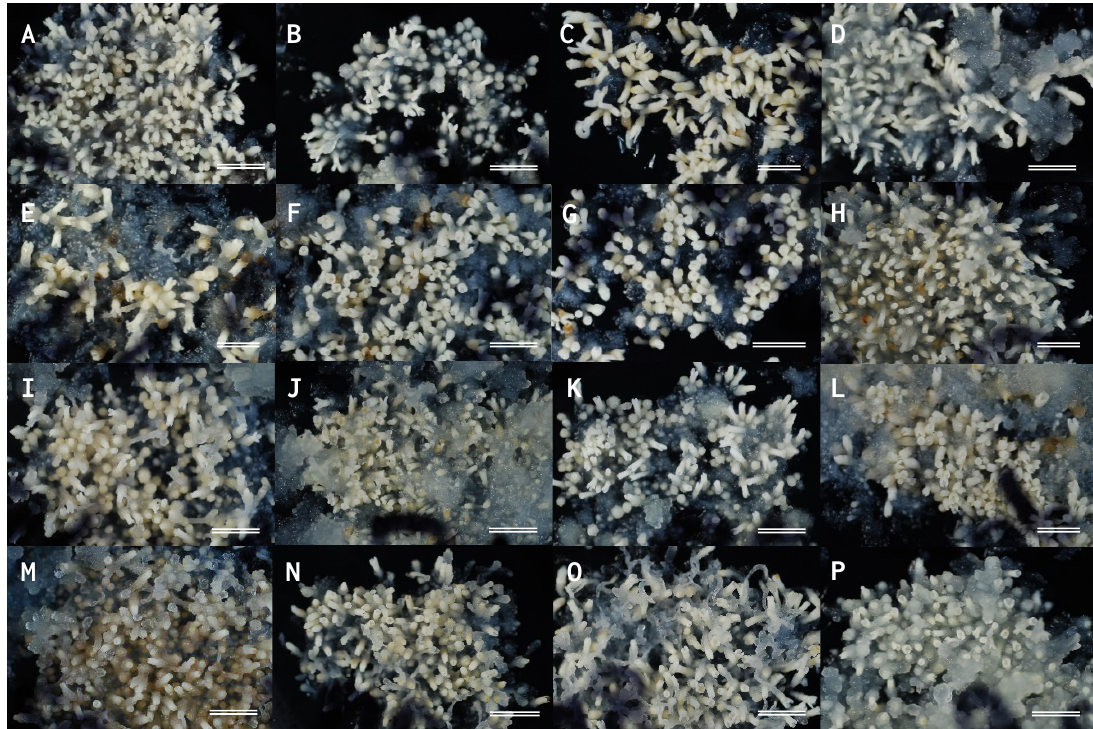
Figure 3. Somatic embryo maturation from embryogenic cells originated from different seed families, ( A – D ) lines from ‘Shindai 3’×’Suzu 2’ family, ( E – H ) lines from ‘Fukushima-funen 1’×’S3-37(1)’ family, ( I – L ) lines from ‘Fukushima-funen 1’×’Oi 7’ family, ( M – P ) lines from ‘Fukushima-funen 1’×’S3-118(2)’ family. Bars 1 cm. Plants 2020 , 9 , x FOR PEER REVIEW